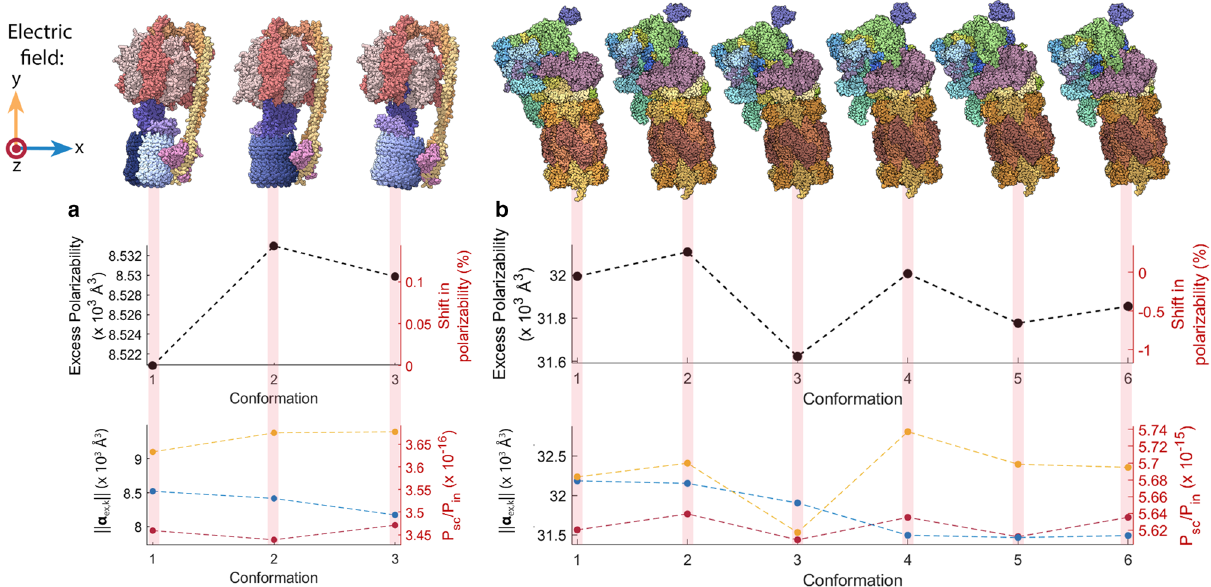
Figure 7. Average excess polarizability (top) and the magnitude of the polarizability vector for three orthogonal x , y , and z ) (bottom) for different conformations of ( a ) chloroplast F 1 F 0 ATP electric field vectors ( k =